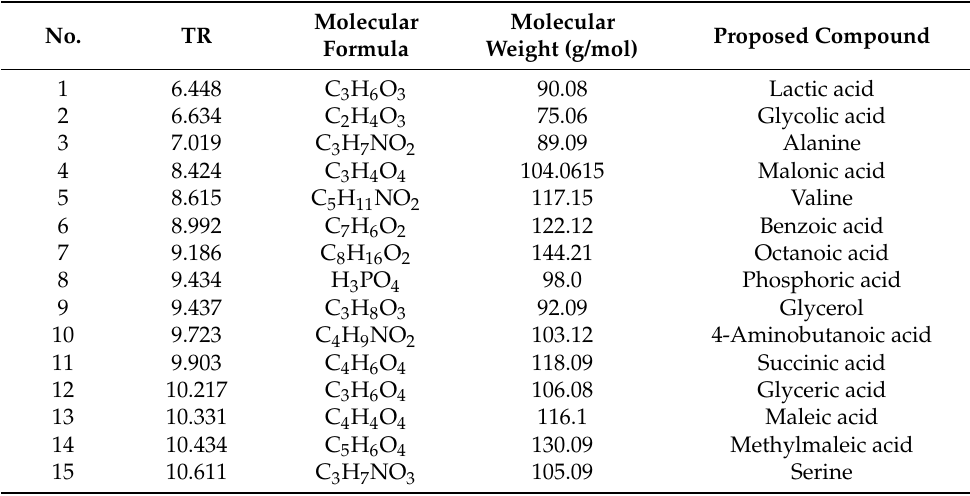
Table 4. Identification of compounds present at the avocado peel by